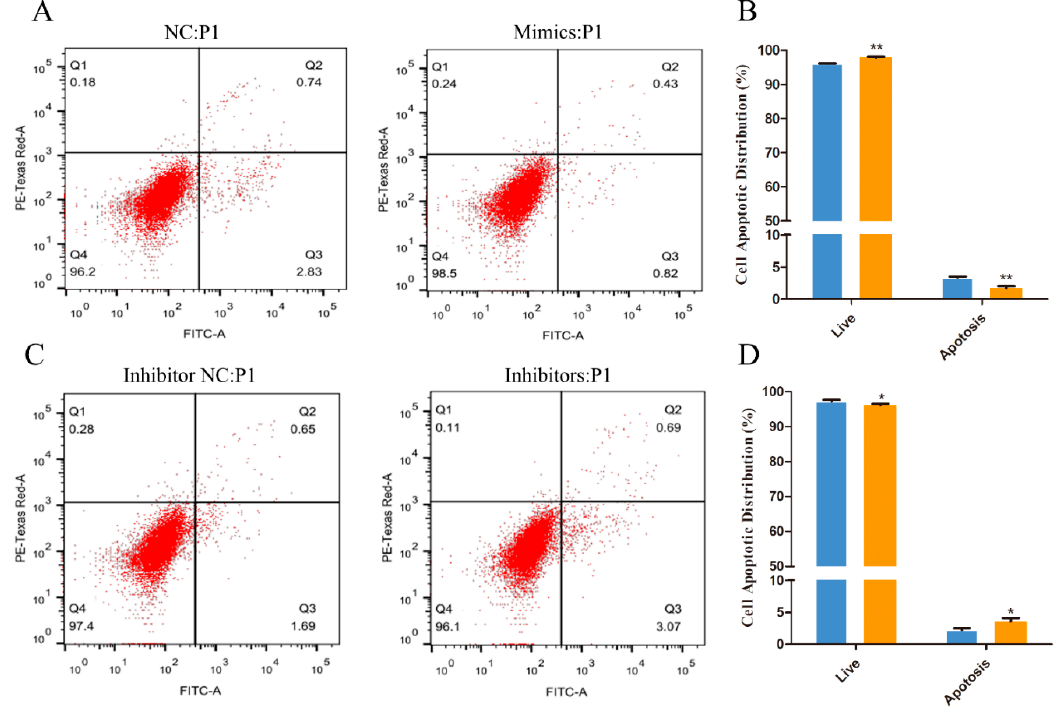
Figure 3. The Annexin V-FITC/PI assay was performed to quantify HFSC apoptotic distribution: ( A , B ) The apoptosis levels of the cells transfected with NC and miR-101 mimics were tested by An- nexin V-FITC/PI kit and flow cytometry; ( C , D ) The apoptosis levels of the cells transfected